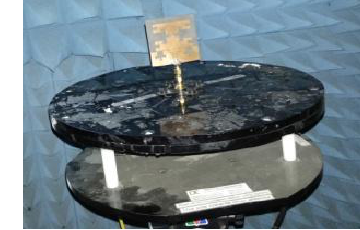
Figure 8: Fabricated antenna in anechoic chamber